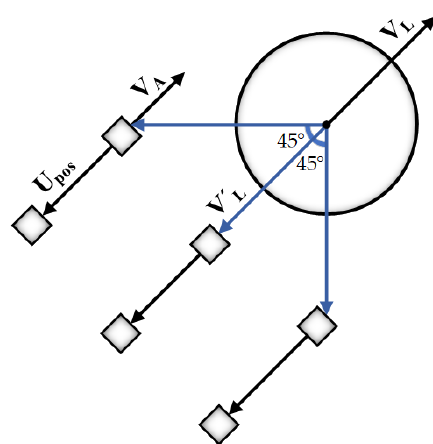
Figure 2. An approximate sample of position production for a uniform formation. The first line will be computed directly from the leader’s unit velocity and other positions by the weighted sum of the velocities related to the leader ( V L ) and the agent ( V A ) in the upper line of the